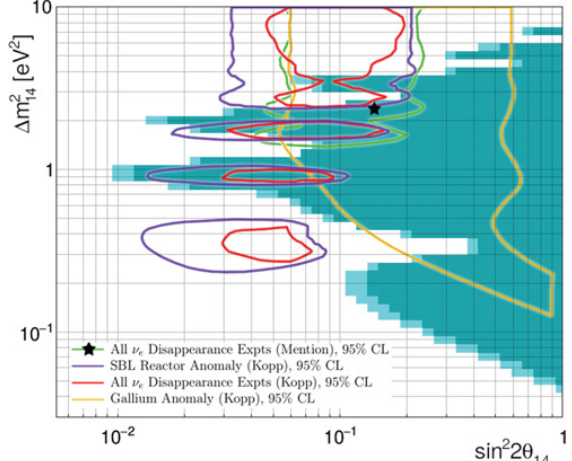
Figure 11. 90% (light cyan) and 95% (dark cyan) CL exclusion , sin 2 2 θ area in (cid:2) m 2 14 parameter space. The shaded area 14 = 1 . 4 eV 2 ). represents our analysis. Curves show allowed regions from 14 neutrino disappearance experiments [4,21], and the star is the = best point from the RAA and GA fit 14